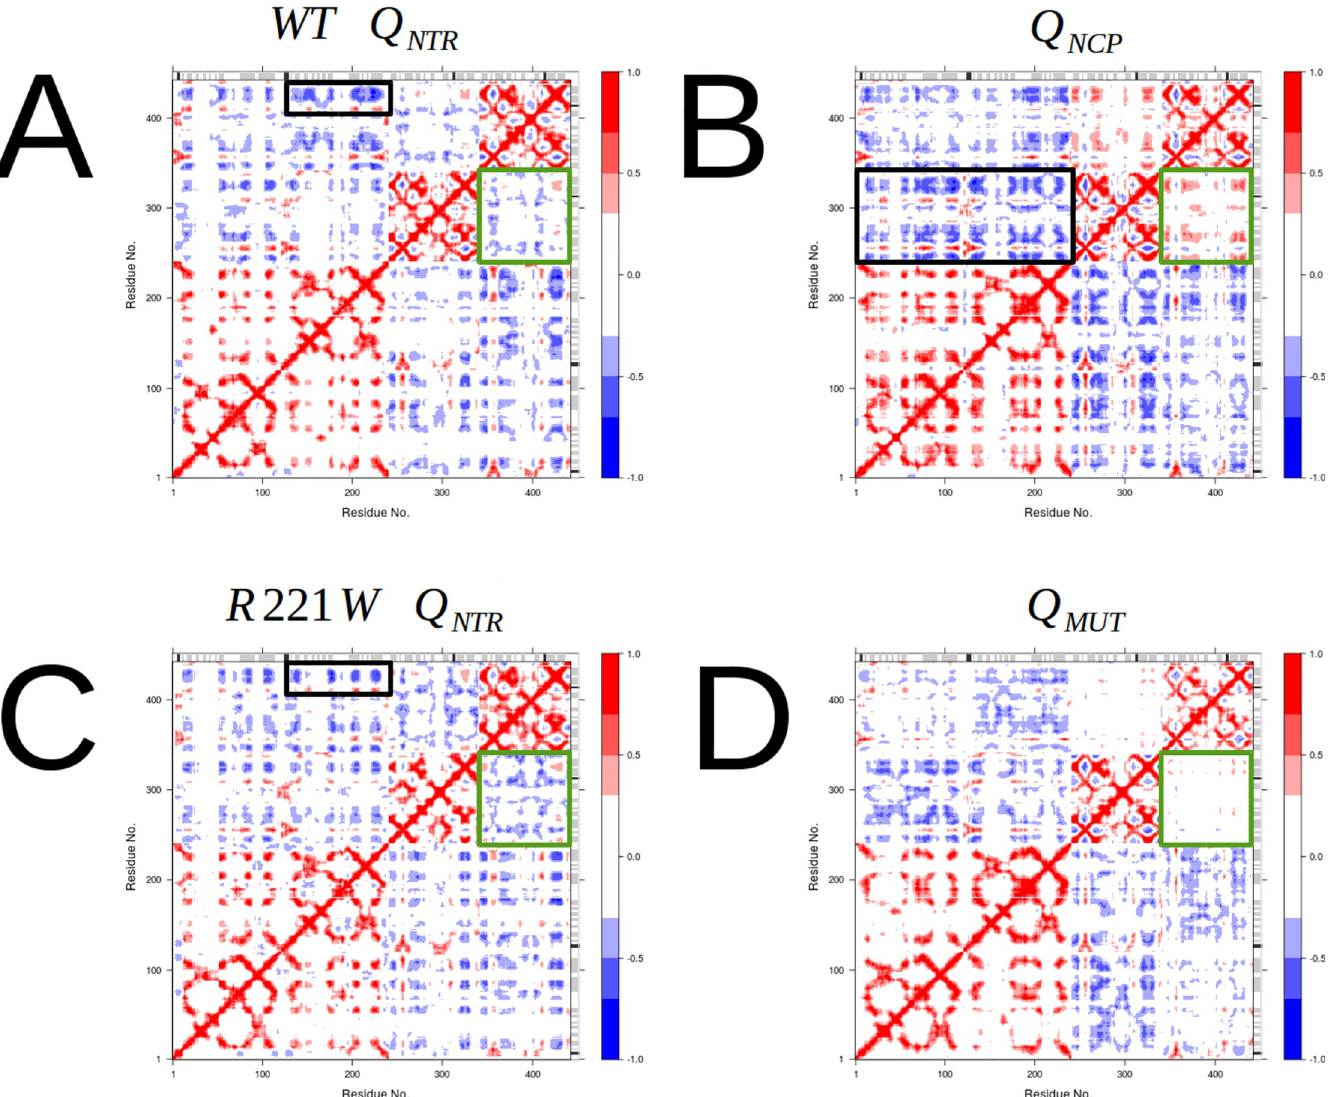
Fig 6. Dynamic Cross-Correlation Map (DCCM) of atomic displacements for all residue pairs in different types of motions. (A) DCCM of WT Q NTR motions. TrkA chains show moderate anti-correlation between them (green square). The NGF B and TrkA B chains have strongly anti-correlated residues (black rectangle). (B) DCCM of Q motions. TrkA chains show a more consistent moderate correlation with each other (green square), indicating that they move in a coordinate fashion in NCP the same direction. The same was observed for NGF. Also, more strongly anti-correlated residues were observed involving all chains (black rectangle). (C) The DCCM of the R221W Q motions have a very similar pattern to that of the WT NTR . (D) The DCCM of the Q NTR the structure in these motions. TrkA chains are uncoordinated (green square).